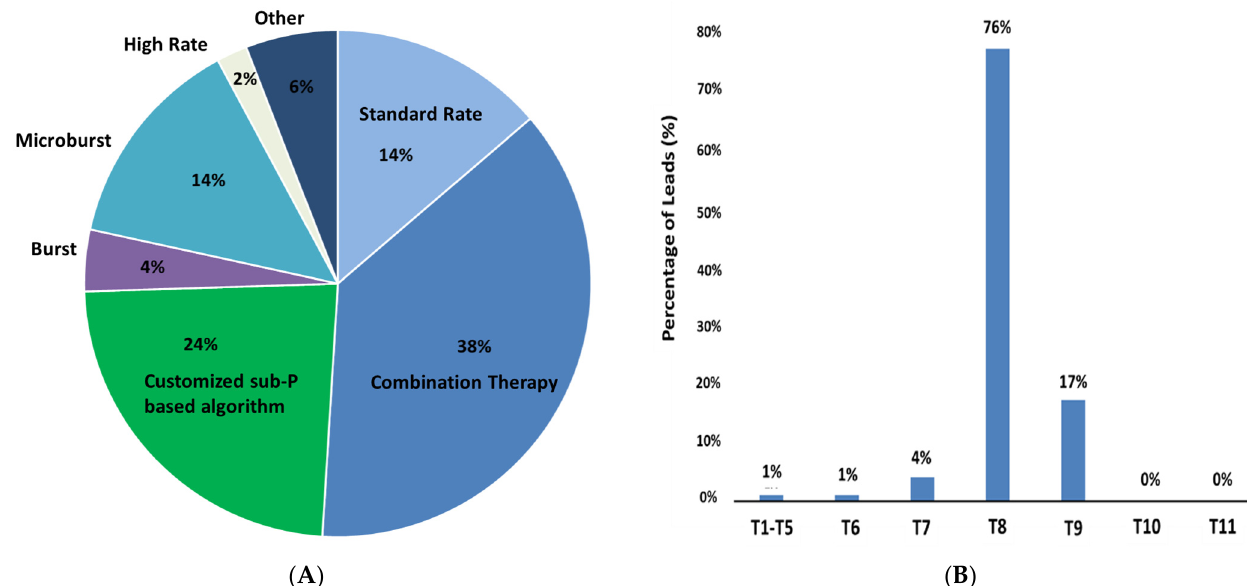
Figure 3. ( A ) Patient preferred programs at last follow-up. Combination Therapy is the ability to allow for simultaneous delivery of sub- and supra-perception stimulation modalities. Customized sub-perception-based algorithm designed to engage anti-nociceptive terminals over a broader area producing a stronger dorsal horn effect. ( B ) Vertebral location of top of implanted dual 16-contact leads ( n = 69).